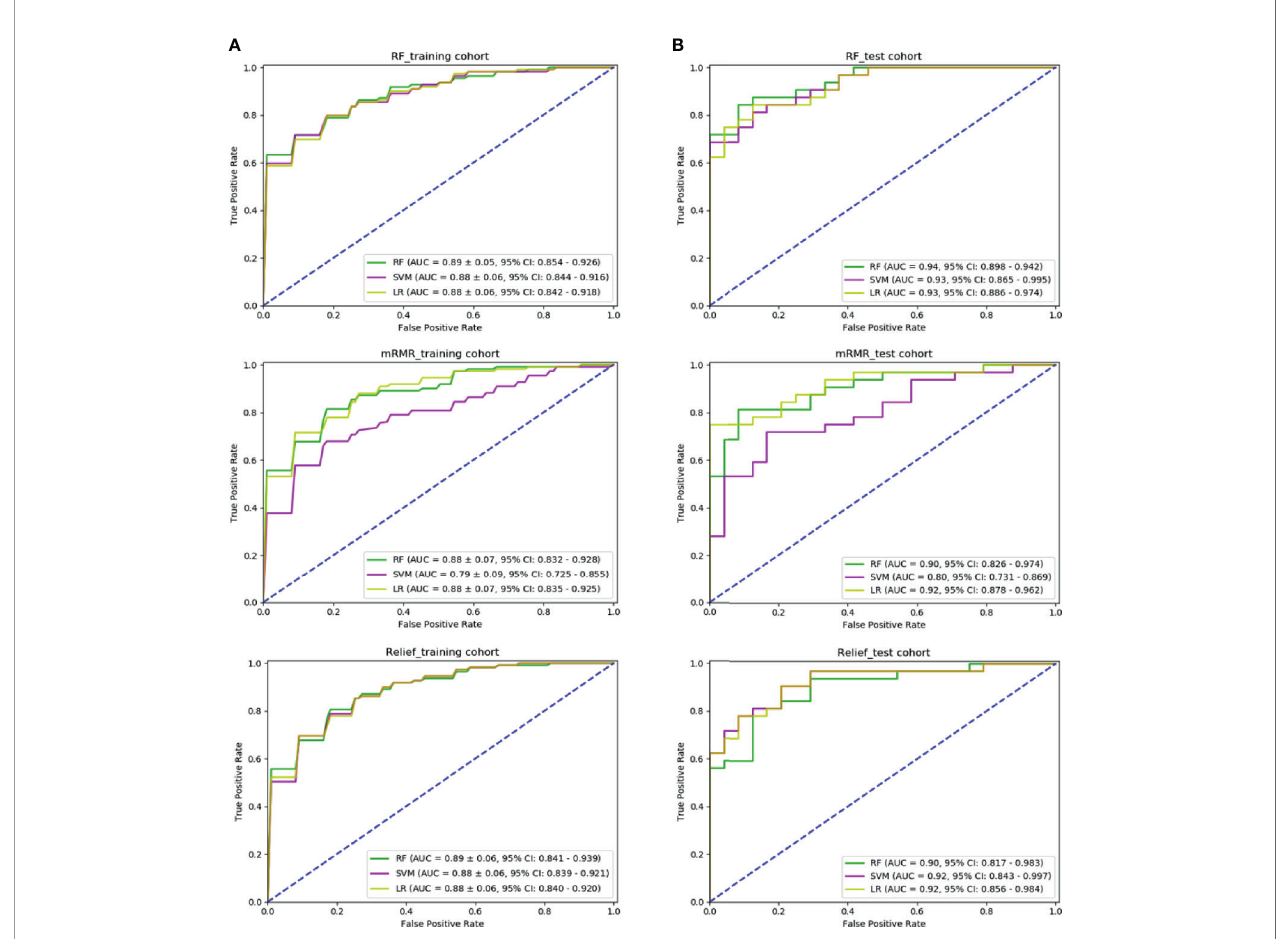
FIGURE 5 | Comparison of predictive models with different classi fi ers and different methods of feature selection: (A) ROC curve of three models using features selected by RF, mRMR, and relief in the training cohort; (B) ROC curve of three models using features selected by RF, mRMR, and relief in the independent test cohort.